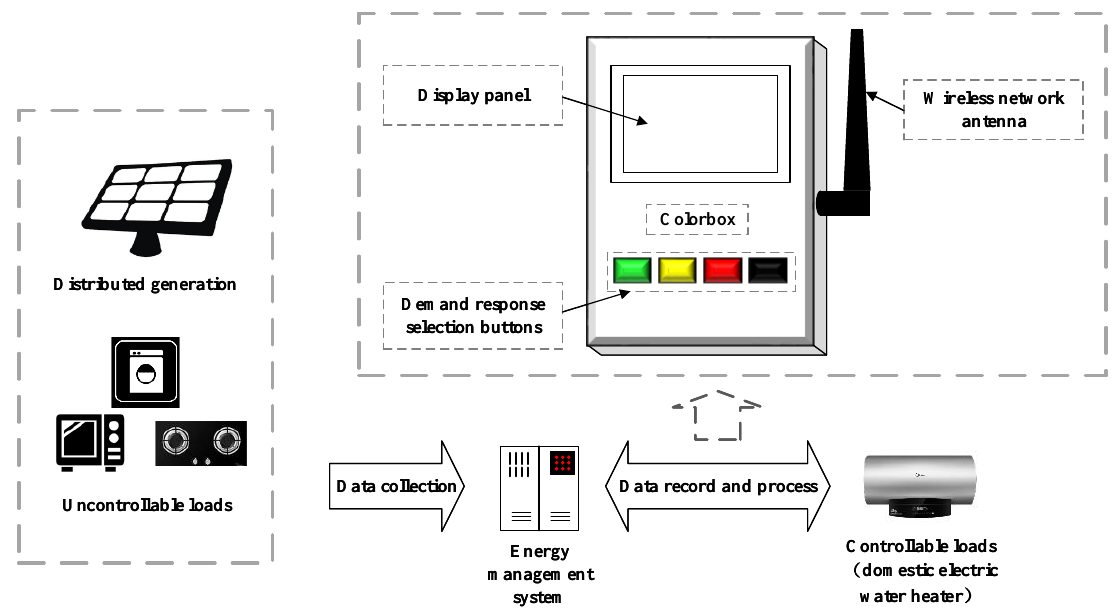
Figure 2. Domestic electric water heater control system.